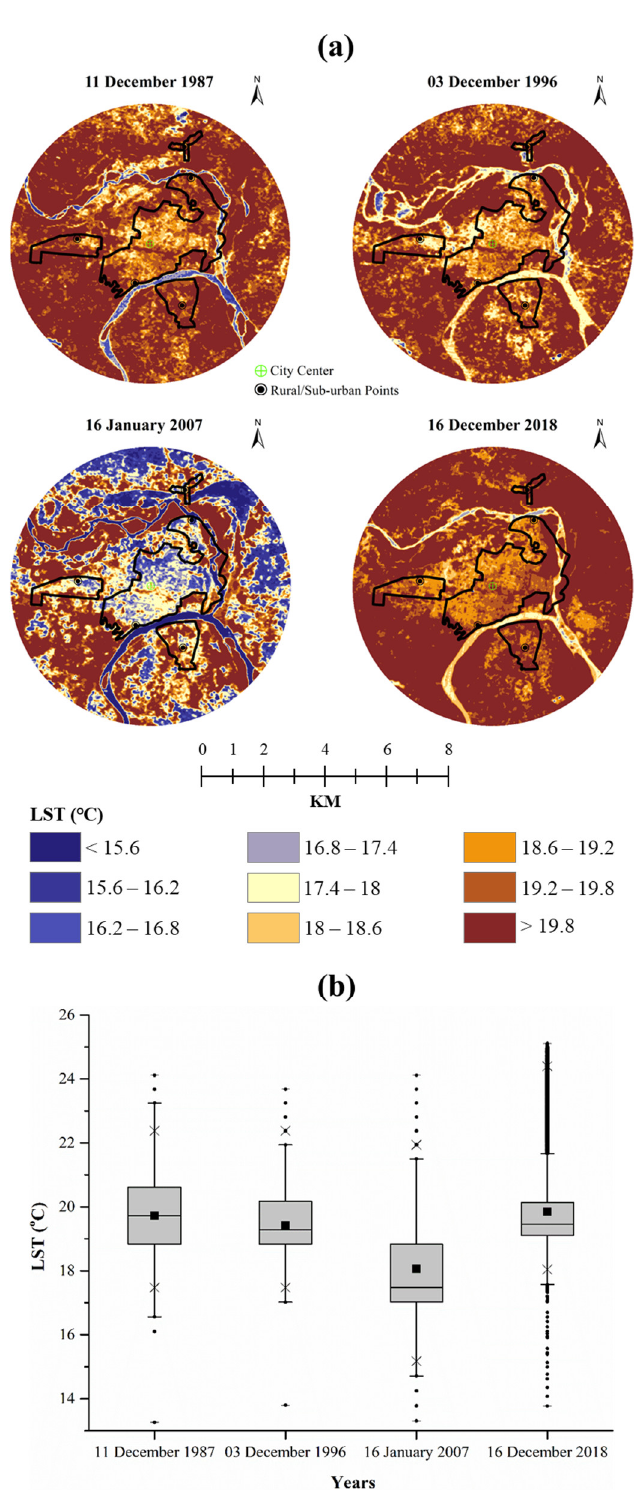
Figure 4. Spatiotemporal dynamics of LST (°C) in winter season over Prayagraj city: ( a ) LST maps during 1987–2018 (five rural/suburban areas shown here used for computing SUHI) and ( b ) boxplots of LST dynamics during 1987–2018.